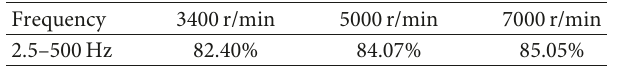
Table 6: The goodness of fit of VPA at different speeds.